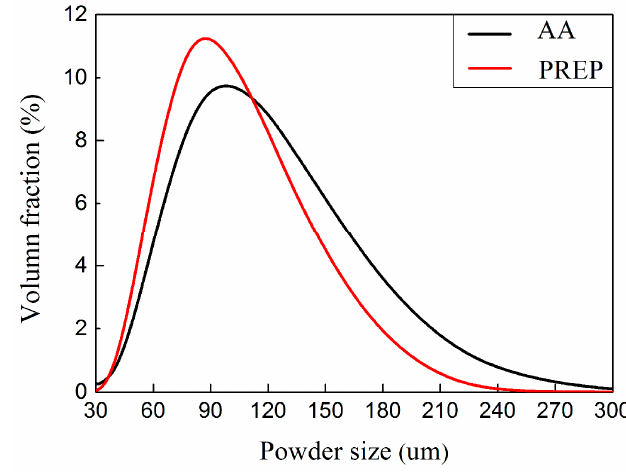
Figure 1. SEM morphology of pre-alloyed GH4099: ( a,b ) GA; ( c,d ) PREP.